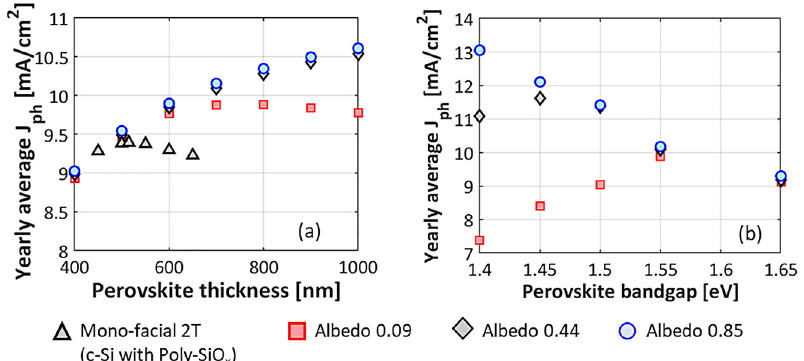
Figure 8: Yearly average photocurrent density of bi-facial 2T tandem module with c-Si bottom cell passivated with poly-SiO x computed in Rome (Italy,tilt =27 ° ,azimuth=South) for differentalbedo valuesandas functionof (a) perovskiteabsorber thickness or (b)perovskite absorberband gap (thickness fi xed to 700 nm). The black triangles values are the reference from mono-facial 2T tandem cell; instead, red squares values are related to the mean albedo value of sandstone (0.09); the black diamonds to that of dry grass (0.44); and the blue circles to that of snow